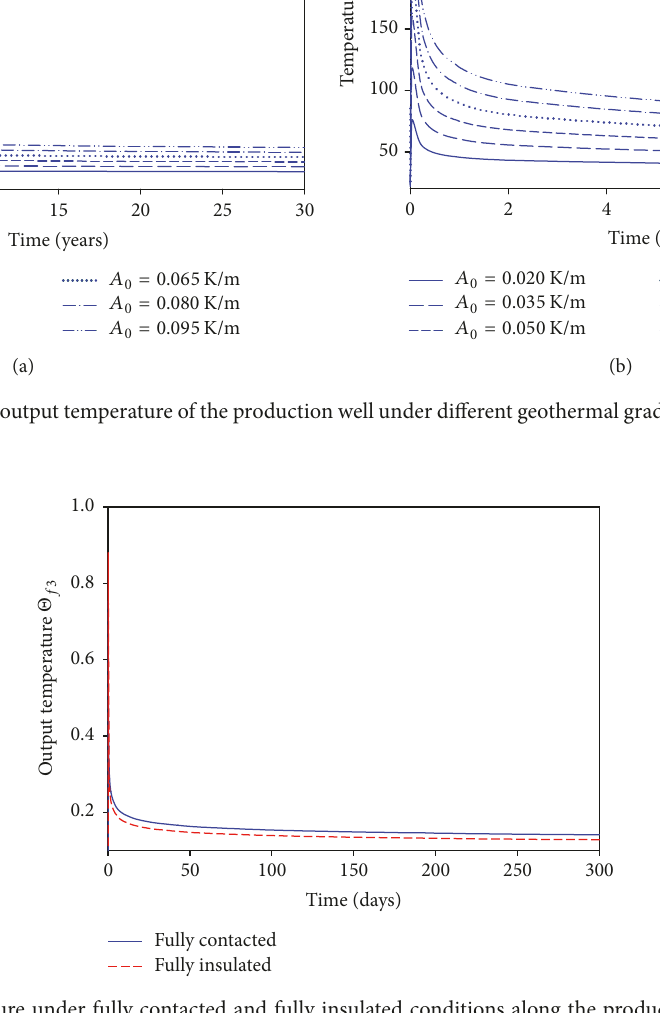
Figure 12: Production temperature under fully contacted and fully insulated conditions along the production well when 𝑄 = 0.05 m 3 /s, 𝐿 = 3500 m, and 𝐿 = 6000 1 2